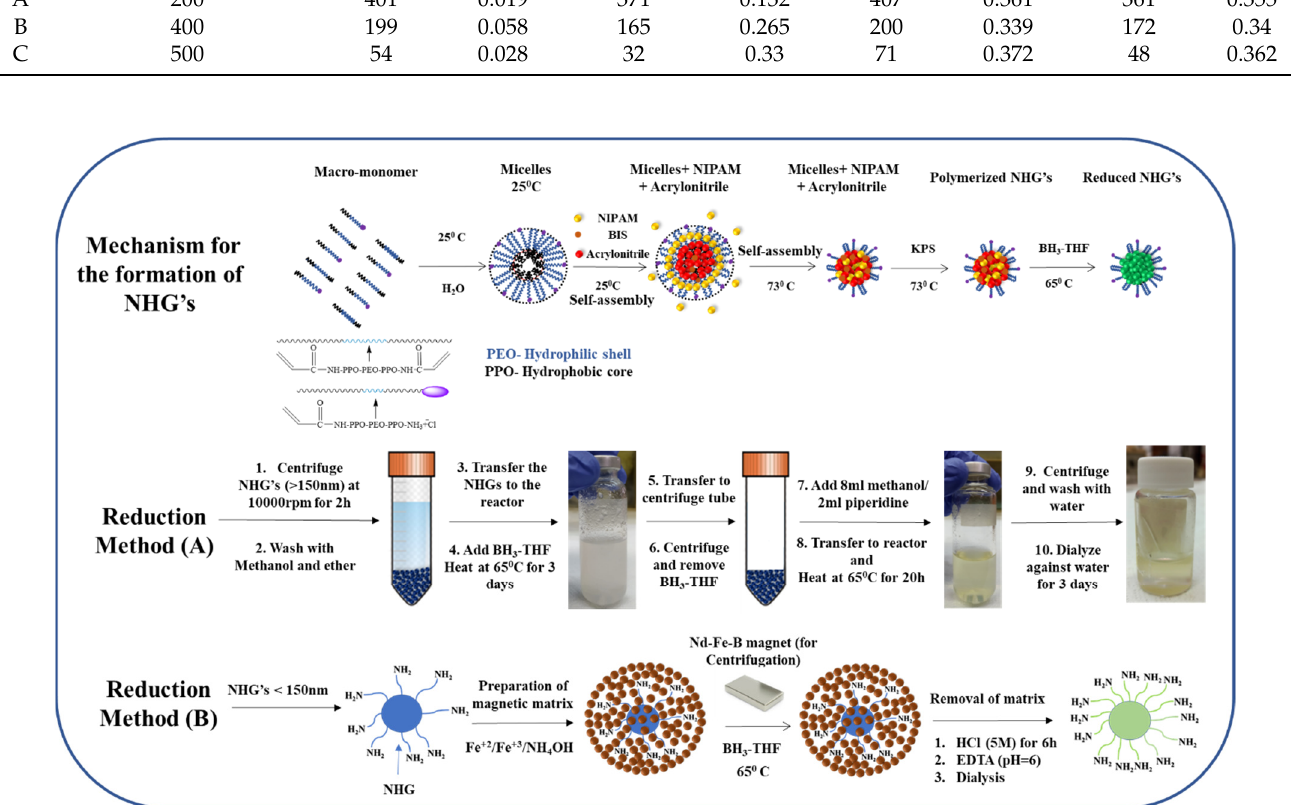
Figure 1. The mechanism for formation of NHG’s and reduction methods.